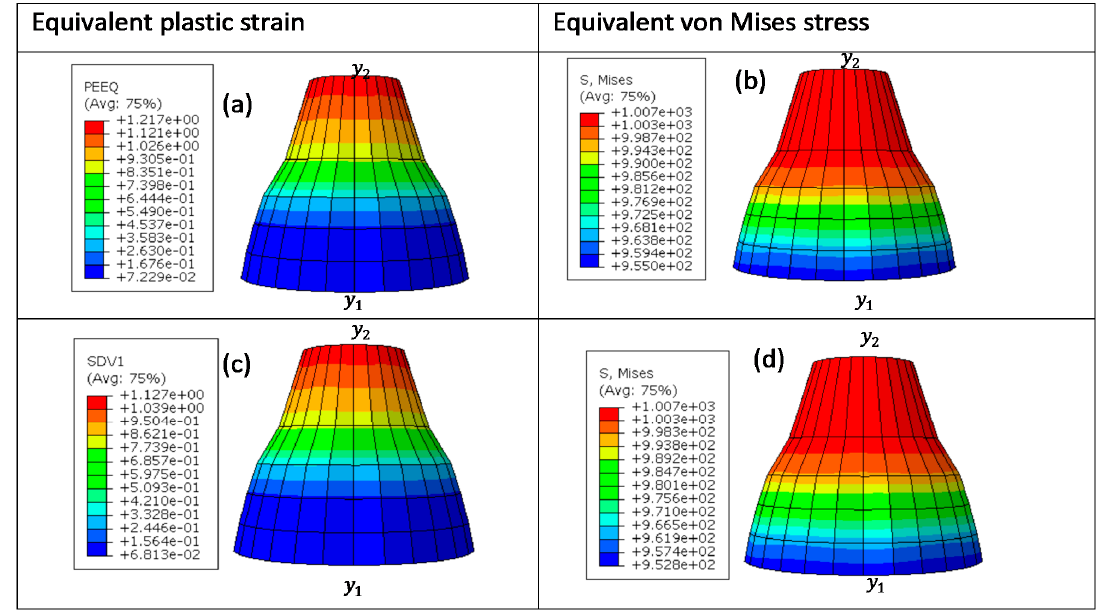
Figure 13. Numerical estimation of ( a , c ) equivalent plastic strain and ( b , d ) equivalent von Mises stress distribution in ( a , b ) VUHARD and ( c , d ) VUMAT subroutines developed here, using 2 mm mesh size, at a test velocity of 4 m/s and temperature of 298 K.